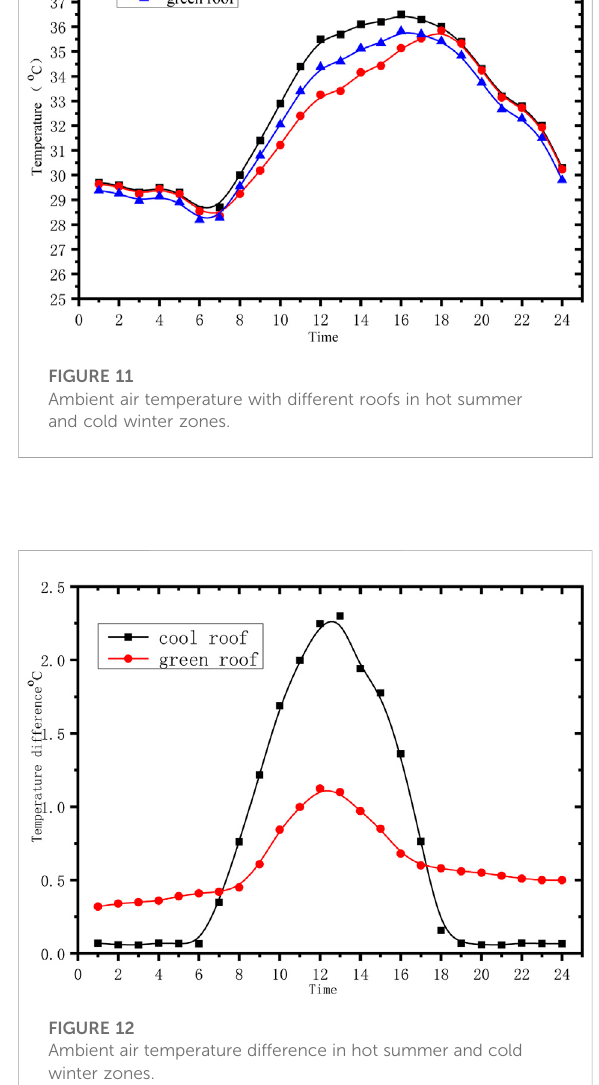
ordinary roof and the modi fi ed roof (cool roof and green